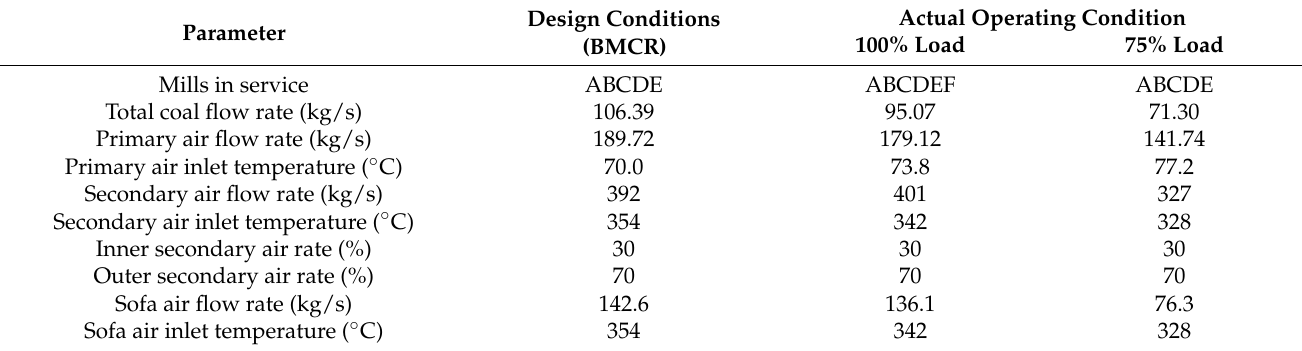
Table 1. Operating conditions of the boiler for 100% and 75% load